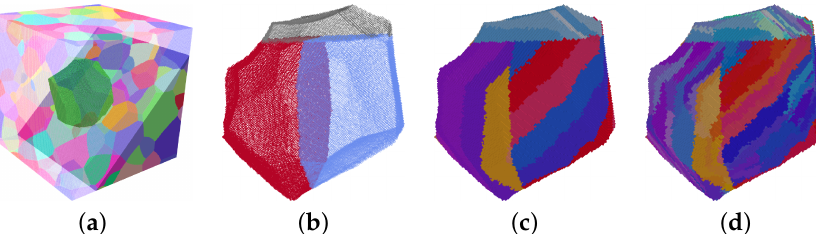
Figure 3. Creation of a martensitic microstructure from an austenitic microstructure: ( a ) Austenitic microstructure with highlighted grain. ( b ) Division of the grain in 3 packets. ( d ) Creation of the subblocks. ( e ) Creation of the laths by means of Voronoi tessellation. Legend for Inverse Pole Figure (IPF) in ( a , c , d ) is given in Figure